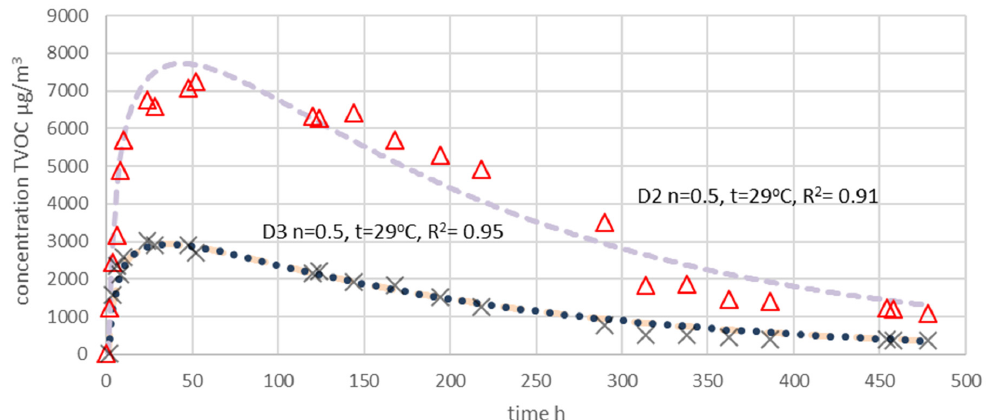
Figure 14. The TVOC emission profiles from D2 and D3 floor systems (tested for 480 h) for the air change rates n = 0.5 h − 1 at 29 °C (and RH=50% for both) in the emission test chamber. (D3 sample is a floor system is made of: water dispersion primer and polyurethane–epoxy adhesive; D2 is made of: polyurethane solvent primer and polyurethane–epoxy adhesive (see Table 3); significant VOCs compounds for these products are provided in Table 1).